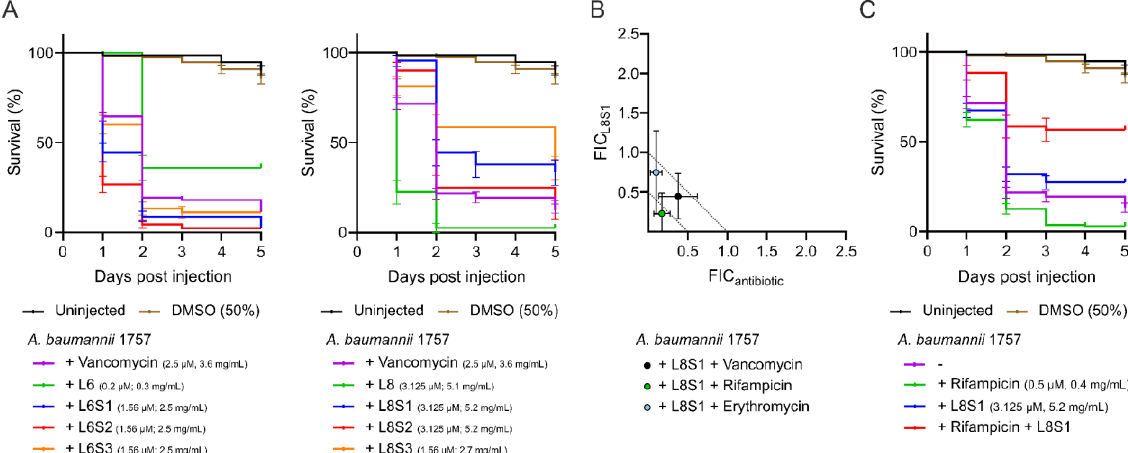
Figure 3. Peptide L8S1 is active in combination with vancomycin or rifampicin against A. baumannii in vivo. Zebrafish larvae survival rates were tracked over time following A. baumannii infection and treatment with stapled peptides, vancomycin or combinations of stapled peptide and vancomycin via caudal vein injection ( A ). MIC values of L8S1, rifampicin or erythromycin, MIC values of L8S1 combined with either rifampicin or erythromycin and MIC values of rifampicin or erythromycin combined with L8S1 were determined via checkerboard assay. The FIC values were defined as either the ratio of L8S1 in combination with rifampicin or erythromycin over the MIC value of L8S1 alone (FIC L8S1 ), or the ratio of the MIC value of rifampicin or erythromycin combined with L8S1 over the MIC value of rifampicin or erythromycin alone (FIC antibiotic ) ( B ). Survival rates of A. baumannii infected zebrafish larvae were additionally followed upon treatment with peptide L11S1, rifampicin or a combination of L11S1 and rifampicin ( C ). The data are presented as mean ± standard deviation from three independent experiments.